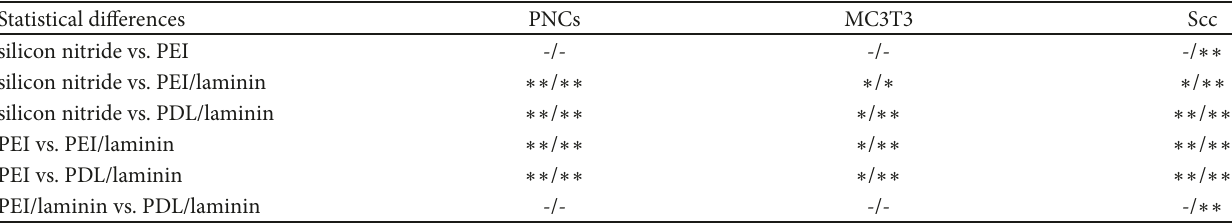
Table 1: Result of the two-way ANOVA analysis of measurement MDFs ( 𝐹 𝑛,𝑠,𝑡 ) and specific MDFs ( 𝐹 the three contact times into consideration. Significance levels are marked for p ≥ 0.05 (none), p ≤ 0.05 ( ∗ ), and p ≤ 0.01 ( ∗∗ ) and separated by 𝑠𝑝𝑒𝑐 a slash ( 𝐹 𝑛,𝑠,𝑡 / 𝐹 𝑠,𝑡